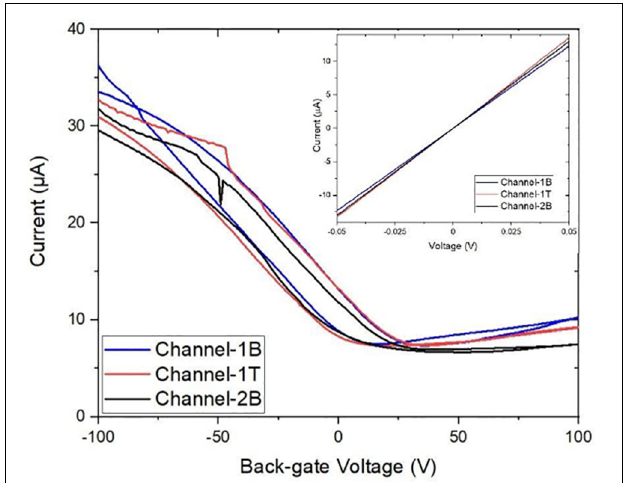
FIGURE 5 | Characteristic transfer curve I D –V G measurements of three graphene channels with corresponding output I D –V D curves (inset). Back-gated measurements showing forward and reverse sweep (from –100 to 100 V) demonstrate the bare graphene channels are electrically almost identical.